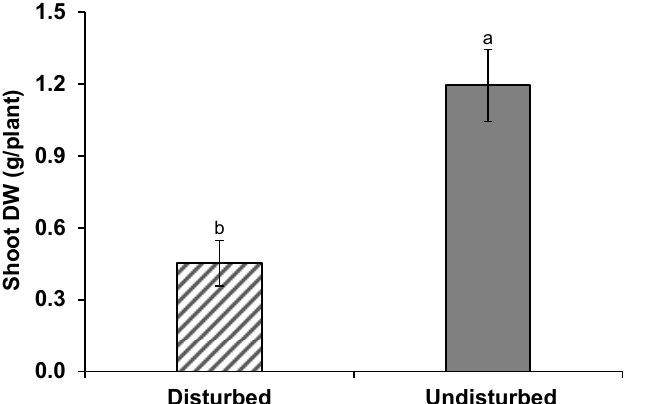
Figure 1. Dry weight (DW) of the shoots of wheat plants grown in disturbed (striped columns) or undisturbed (grey columns) acidic soil, after the growth of Ornithopus compressus . Data are presented as means ± standard error of four independent biological replicates. Different letters indicate statistically significant differences ( p < 0.05).